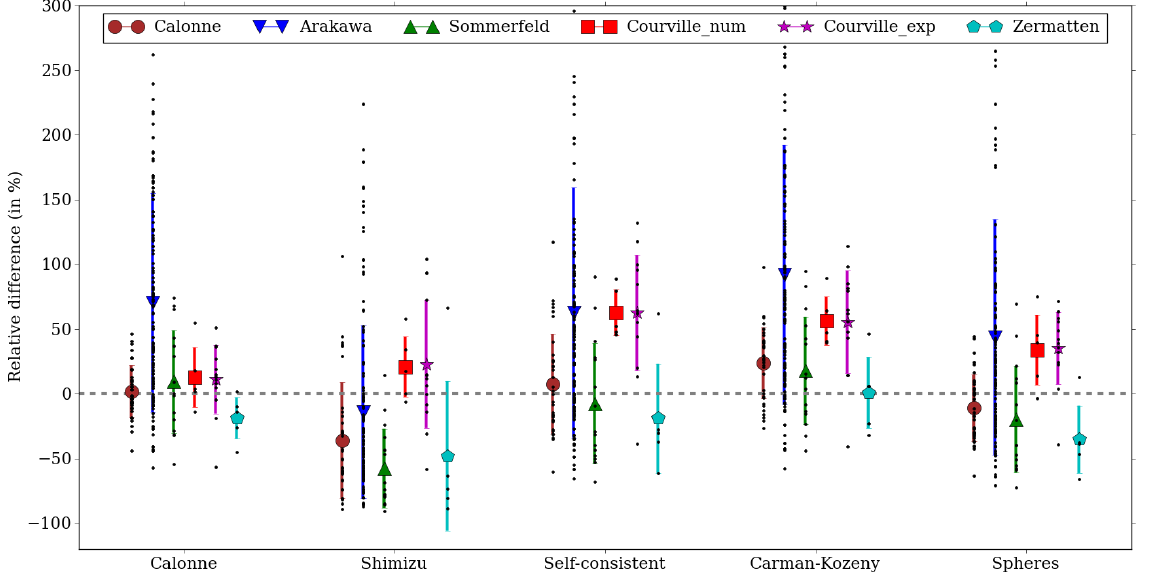
Fig. 5. Overview of the relative differences between experimental or numerically computed values of the intrinsic permeability of snow from six datasets (colors) and their estimates based on the corresponding snow density and equivalent sphere radius using various regression or analytical curves (x-axis). Black dots refer to individual measurements of relative residual. The mean and standard deviation of the relative differences are indicated as symbols and error bars, respectively.